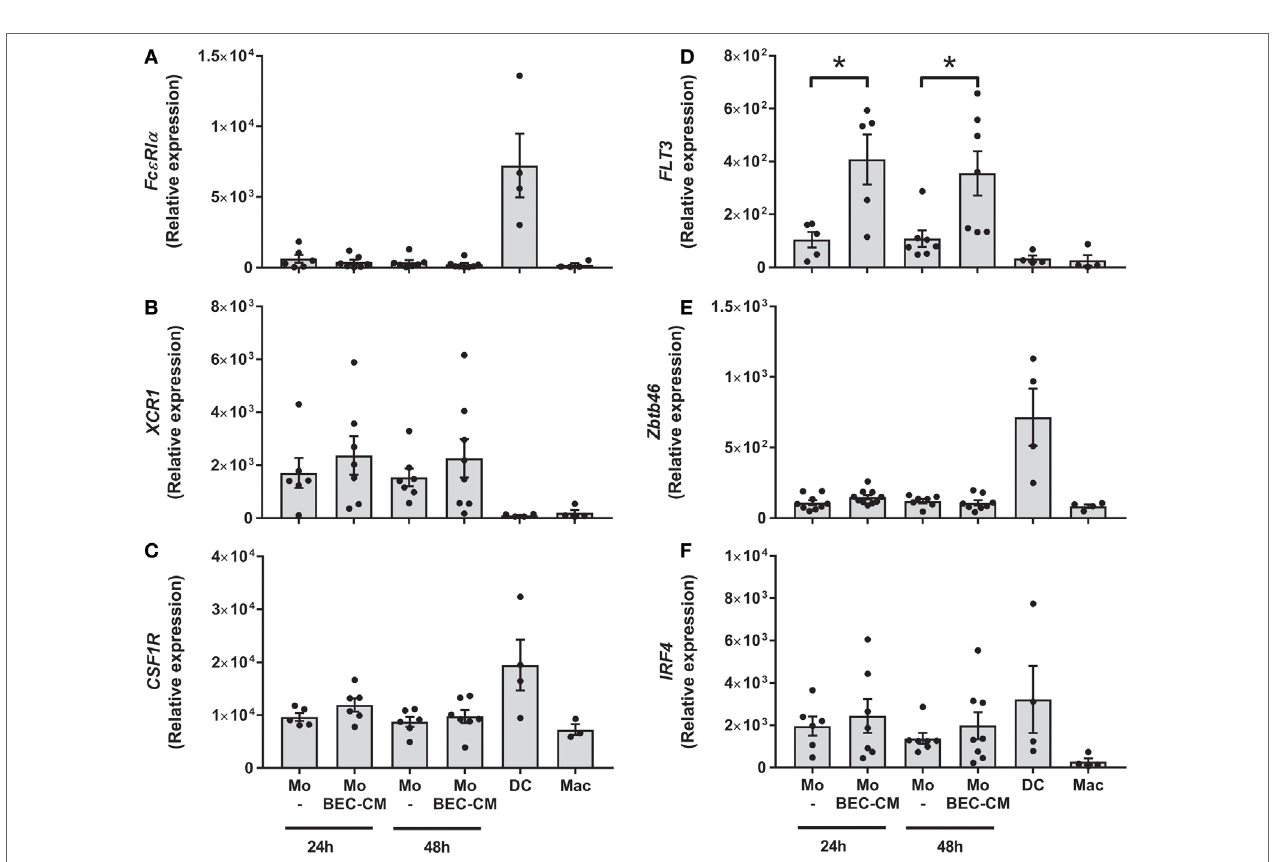
FigUre 2 | expression of monocyte-derived Dc markers in bronchial epithelial cell-conditioned monocytes . Monocytes were cultured for 24 or 48 h with medium alone or with Bronchial epithelial cell-conditioned media (BEC-CM). Gene expression of (a) Fc ε R1 α , (B) XCR1 , (c) CSF1R , (D) FLT3 , (e) ZBTB46 and (F) IRF4 were assessed by the real-time quantitative PCR. Data express the relative gene abundance normalize to the endogenous control β -2-microglobulin (B2M) and are shown as mean ± SEM of four to six independent experiments, done in duplicates. Statistical analysis was performed using analysis of variance test (followed by Tukey multiple comparisons test) (* P <